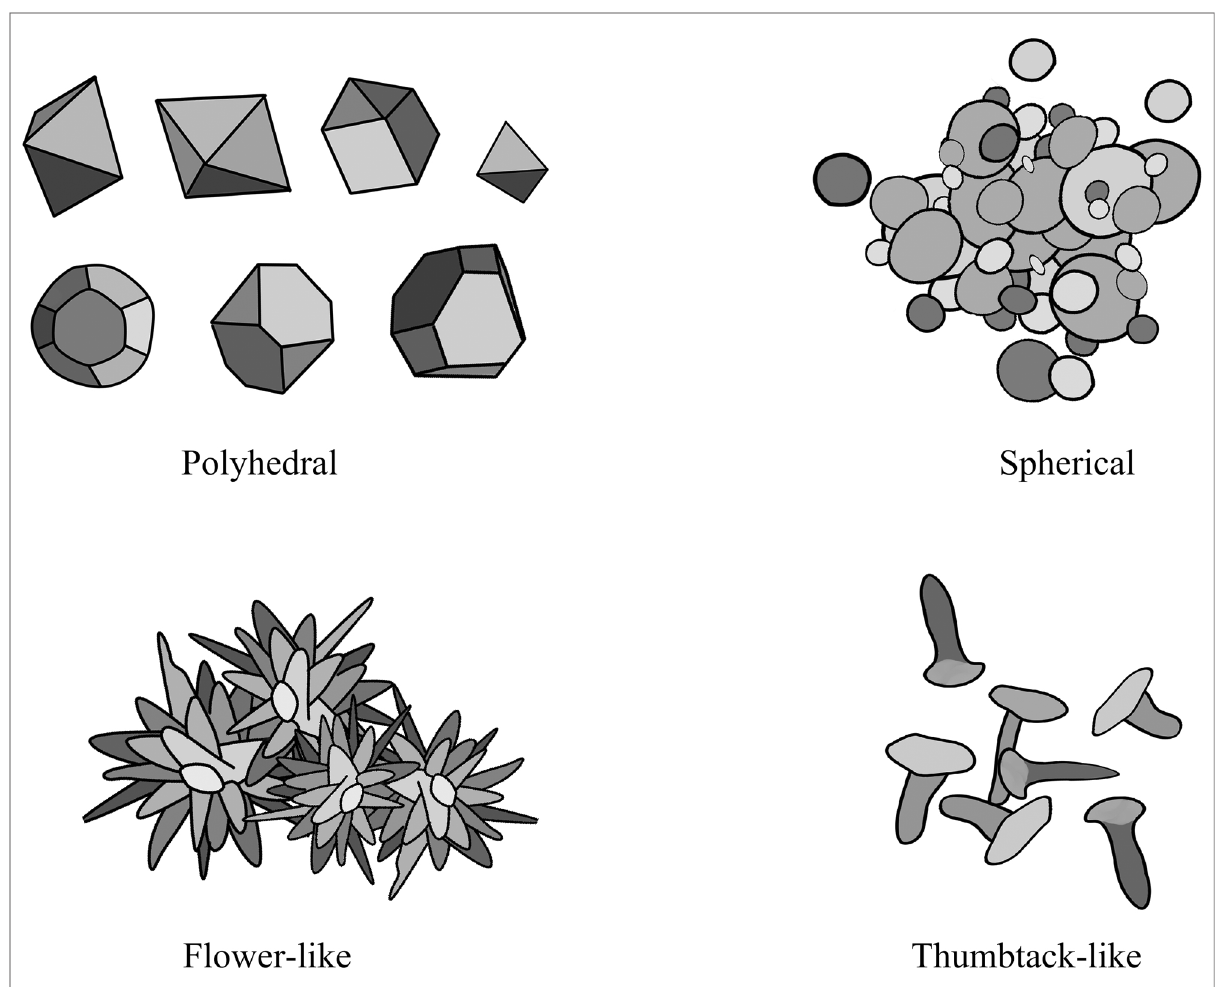
FIGURE 2 Different morphology of Copper-containing